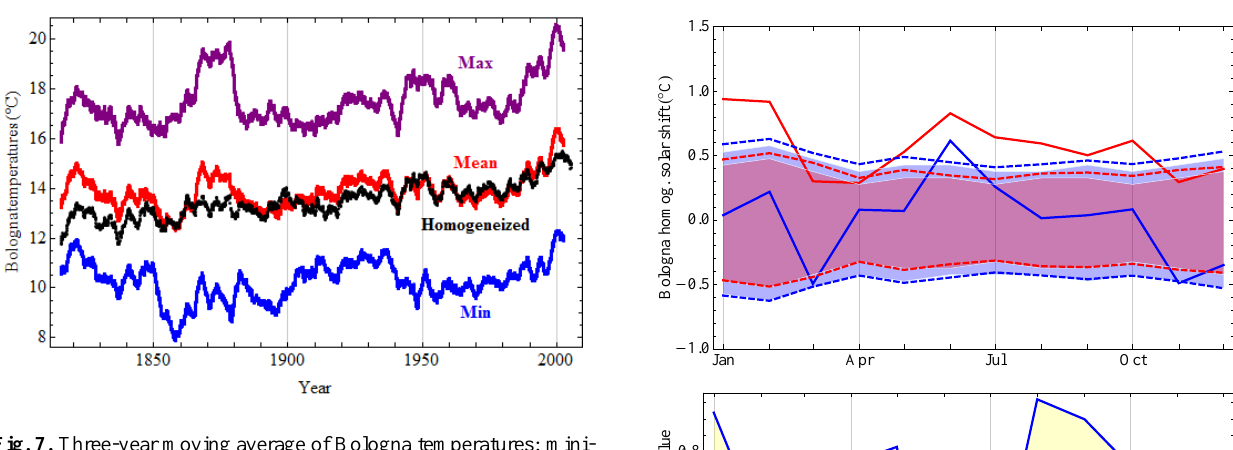
Fig. 7. Three-year moving average of Bologna temperatures: mini- mum (blue), mean (red), maximum (purple) and homogenized mean (black).